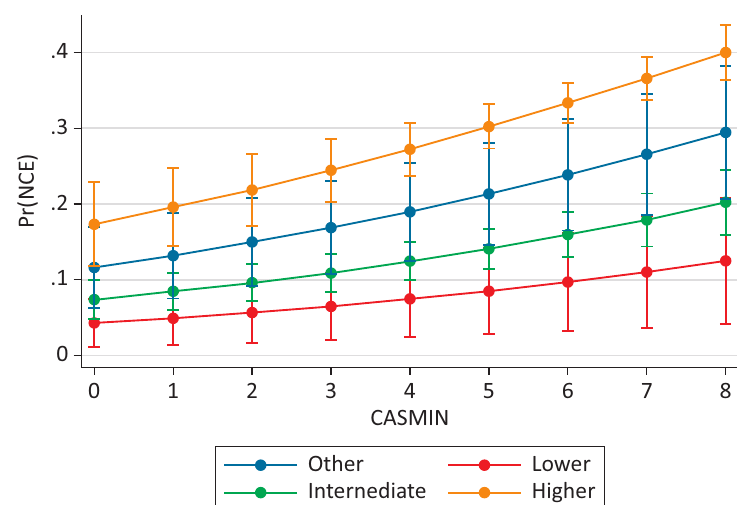
Figure 2. Predicted probabilities of participation in NCE with 95% CIs by secondary education and CASMIN. Social Inclusion, 2021, Volume 9, Issue 3, Pages